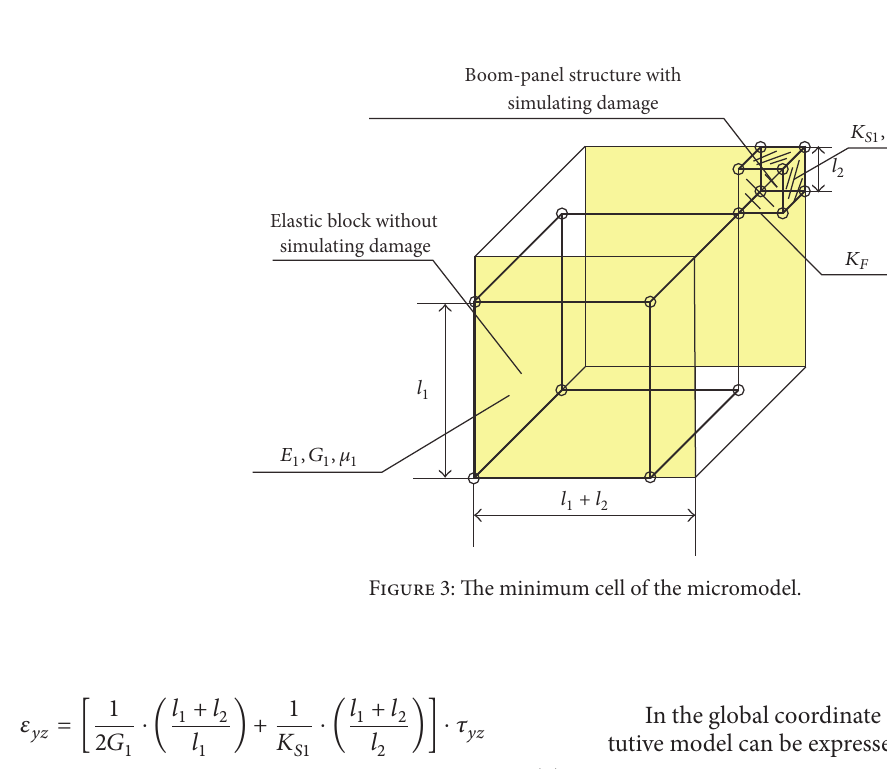
Figure 2: The relationship between one element in the structure and the micromodel.